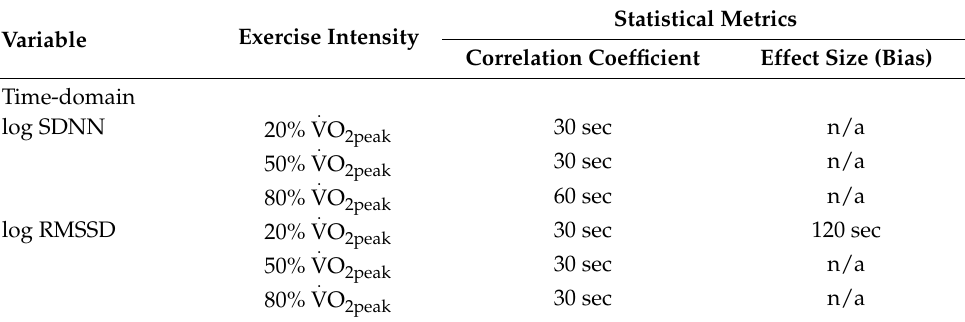
Table 3. The acceptable minimum time segment of HRV analysis in exercise condition according to the statistical